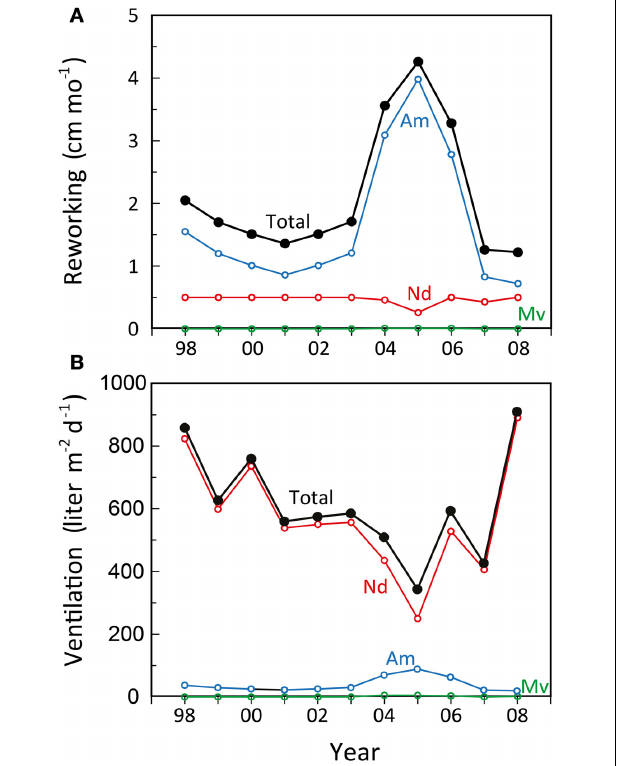
FIGURE 6 | Estimated development in (A) monthly reworking depth and (B) daily ventilation rate during summer (15 ◦ C) by Nereis diversicolor (Nd), Arenicola marina (Am), and Marenzelleria viridis (Mv) populations in the inner Odense Fjord from 1998 to 2008. The black lines indicate the total. Data were obtained from the average biomass at the 4 stations shown in Figure 5 multiplied with the literature-based weight- and time-specific conversion factors for reworking and ventilation as shown in Table 3